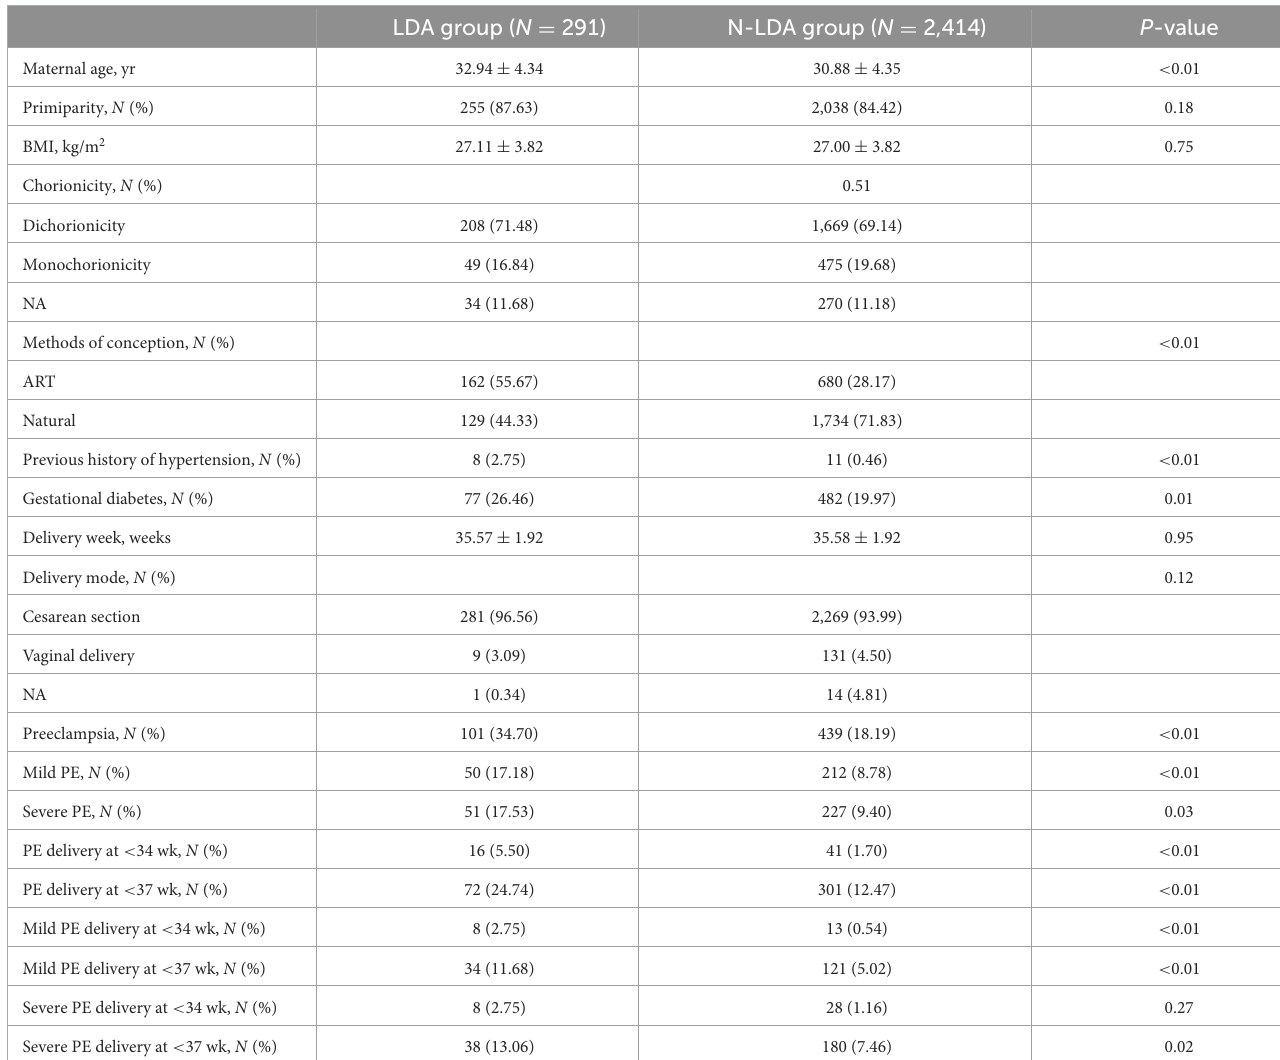
TABLE 1 Demographic characteristics of the